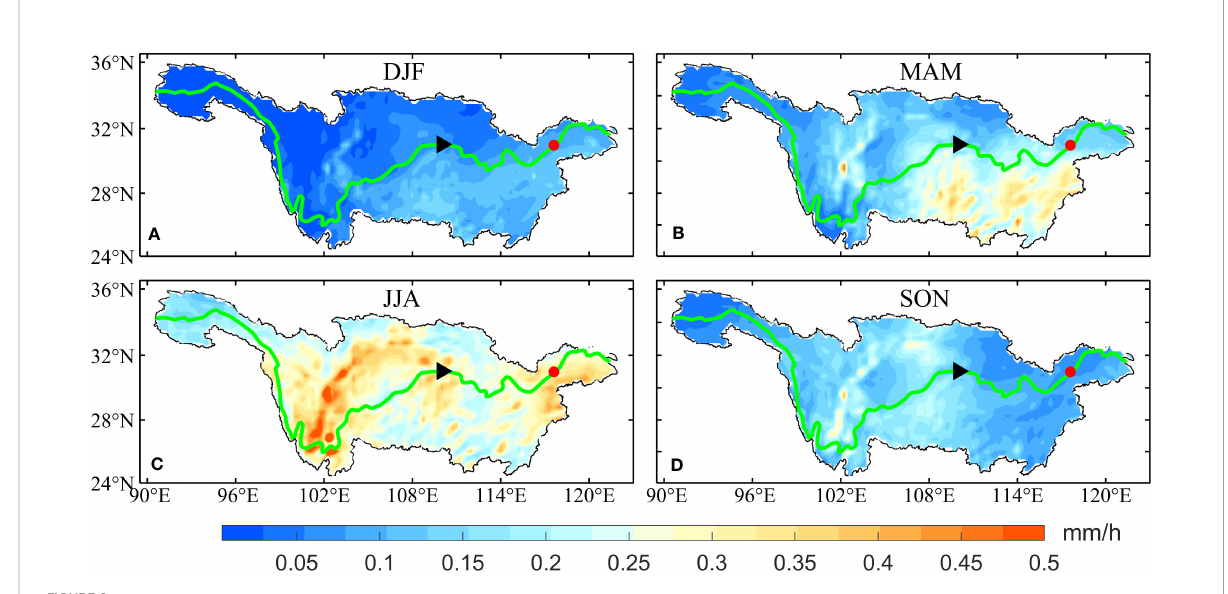
August (JJA), and (D) September – October – November (SON) over the Yangtze River Basin from 2018 to 2021. The black triangle shows the position of the Three Gorges Dam (TGD), and the red dot shows the location of the Datong (DT)